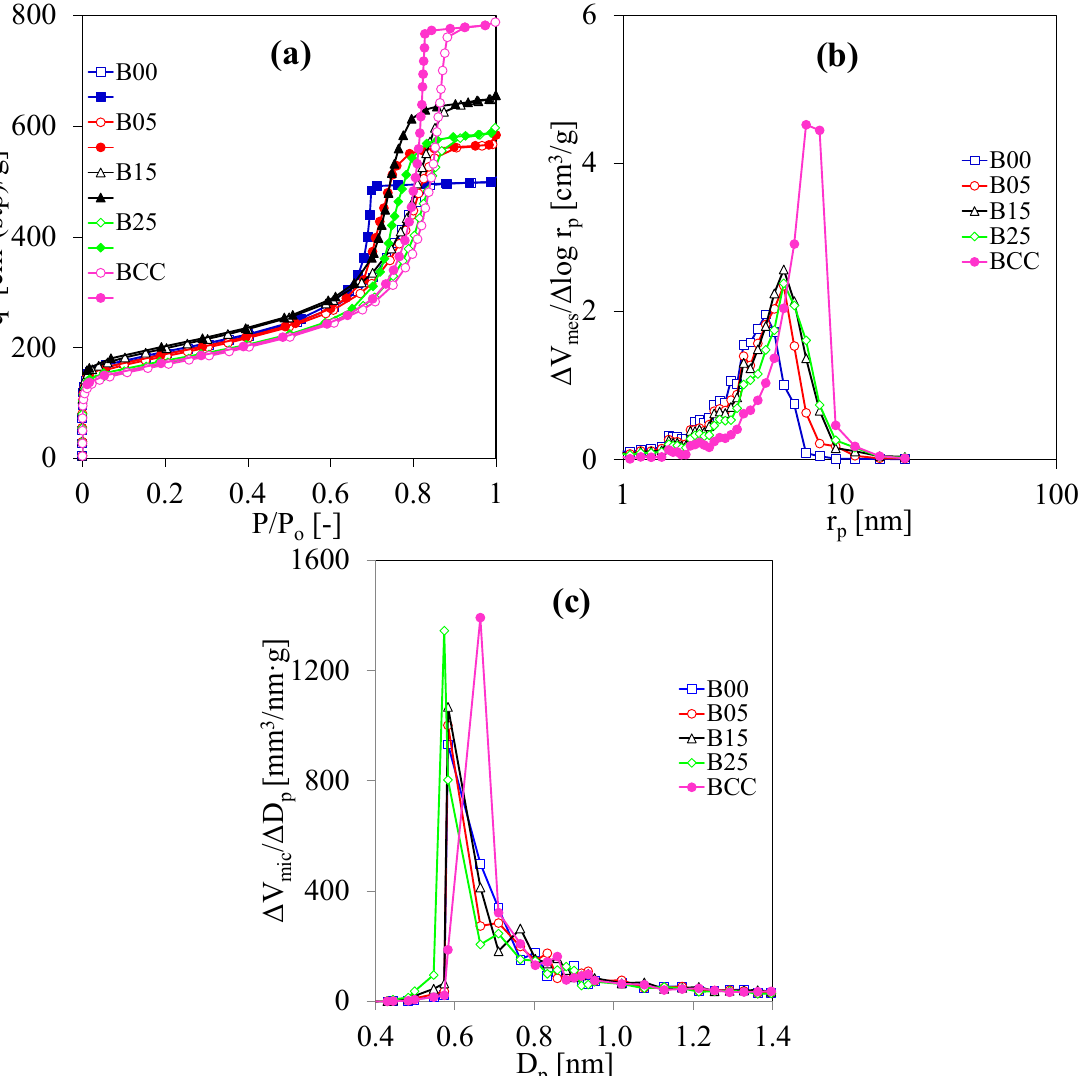
Figure 4. N 2 adsorption analysis of CaF and C/C composite xerogels prepared by using the CF/RF ratio for 0.00–0.25 g/g at R/C = 200 mol/mol and R/W = 0.25 g/cm 3 : ( a ) N 2 adsorption and desorption isotherms at − 196 °C (open symbols = adsorption; closed symbols = desorption), ( b ) mesopore size distribution, and ( c ) micropore size distribution.